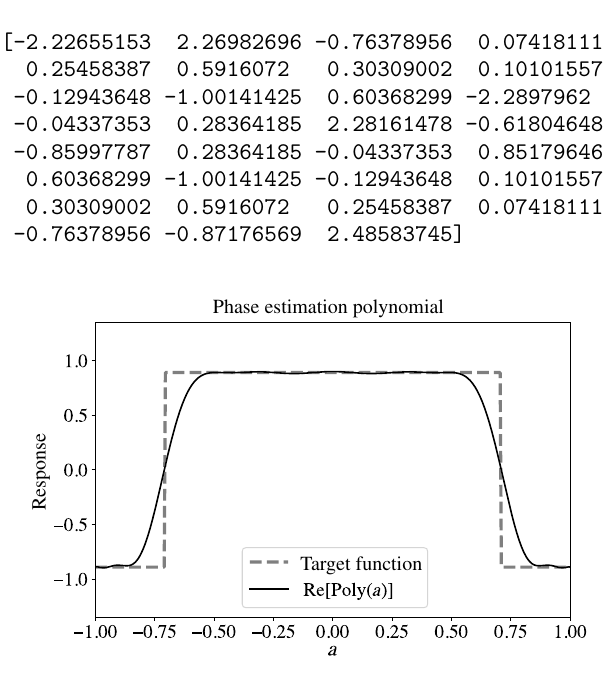
FIG. 27. The response function for the real phase estimation polynomial with (cid:16) = 10 and d = 18 in the ( W x , S z , (cid:8)+| · |+(cid:6) ) - QSP convention.